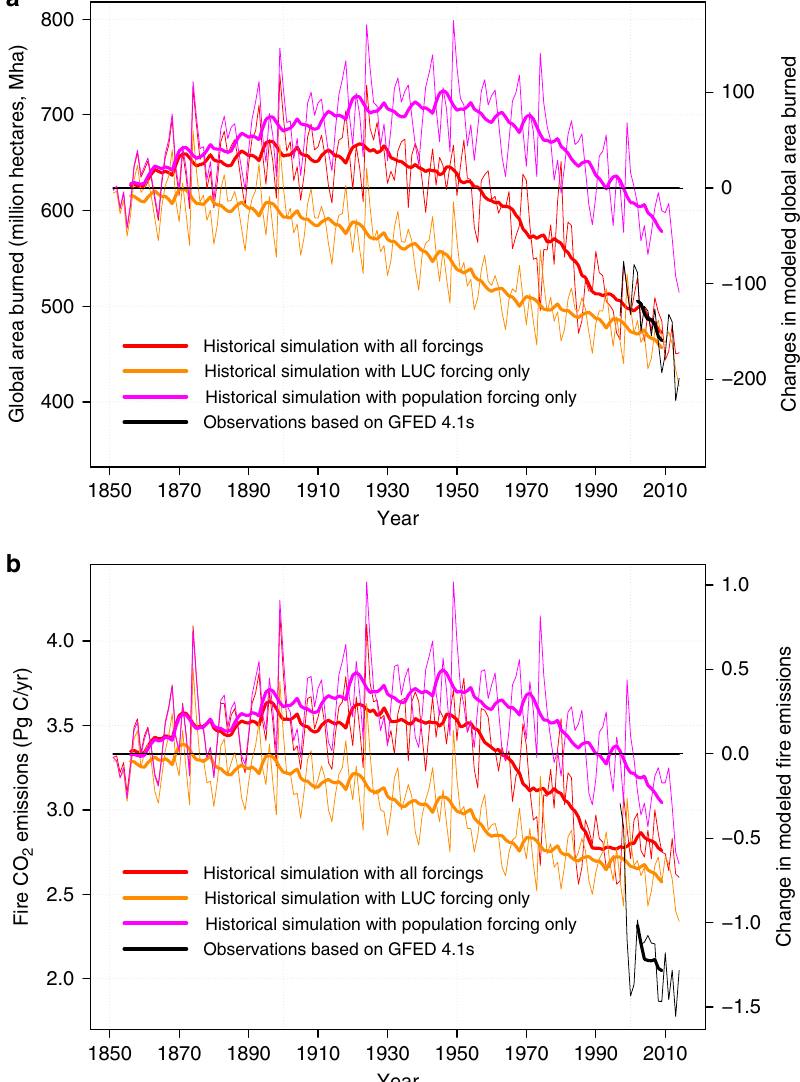
Fig. 1 Simulated global burned area and fi re CO 2 emissions. Global area burned ( a ) and fi re CO 2 emissions ( b ) from the historical simulation driven with all forcings (red line) and driven with population (magenta line) and land use change (LUC) (orange line) forcings individually. The thick lines are the 10-year moving averages. Observation-based burned area (black line) in a is based on the GFED4.1 s data set and emissions in b are based on GFED4.1 s